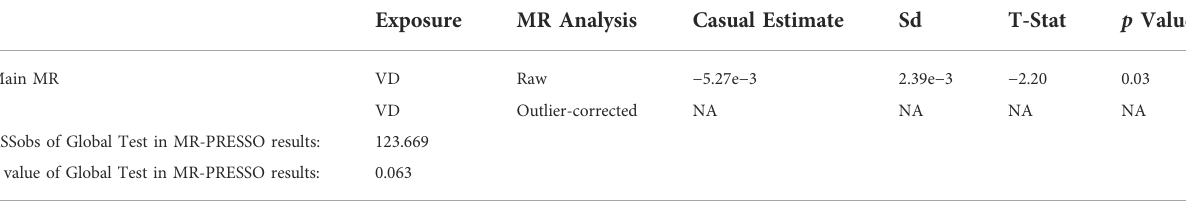
TABLE 5 Pleiotropy testing of instrumental variables for vitamin D using